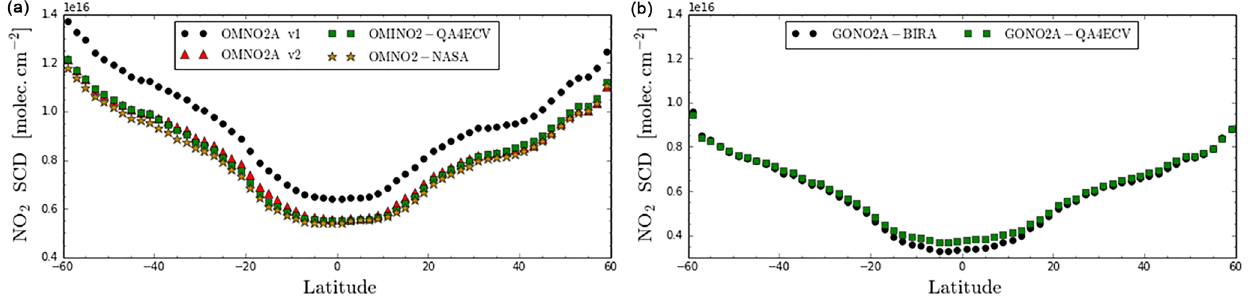
Figure 1. Average NO 2 slant columns within 2 ◦ wide latitudinal bins for OMNO2A v1 (black circles), OMNO2A v2 (red triangles), OMINO2–QA4ECV (green squares), and OMNO2–NASA (yellow stars) algorithms (a) , and for GONO2A-BIRA (black circles) and GONO2A–QA4ECV (green squares) algorithms (b) for the Pacific (reference sector: 60 ◦ N–60 ◦ S and 150–180 ◦ W) orbit from day 1